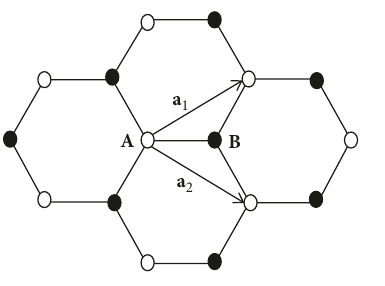
Figure 4: Honeycomb lattice structure of graphene.